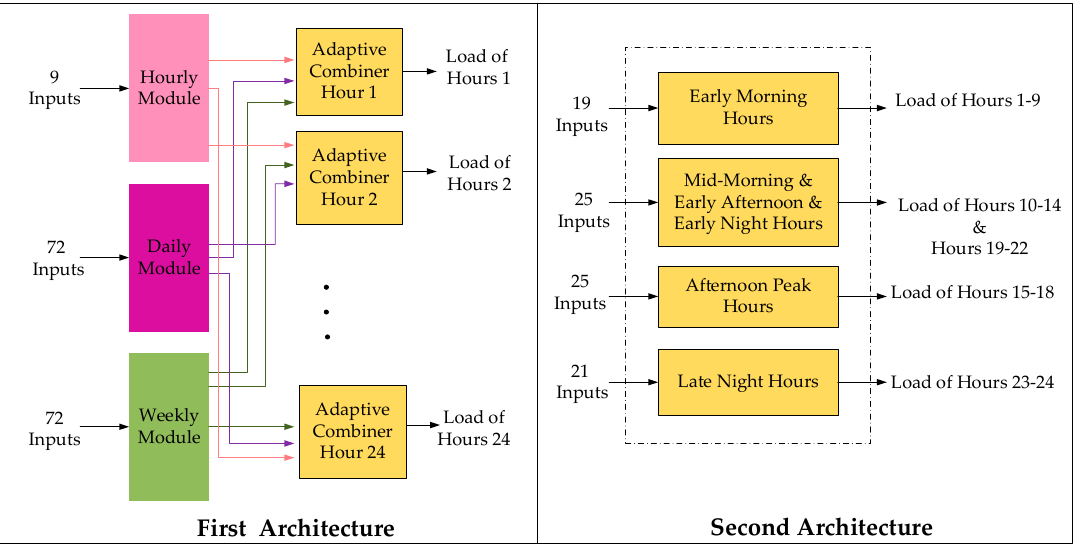
Figure 7. Parallel architecture for 24-hour ahead forecasting proposed in [71].